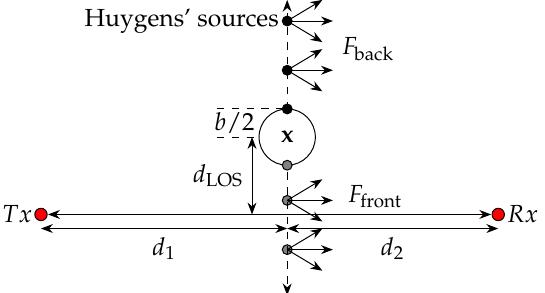
Figure 2. Distances and resulting Fresnel integrals that are required by the radio propagation model c (cid:13) 2019 IEEE, Reprinted, with permission, from